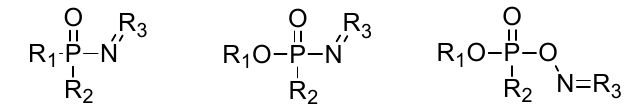
Figure 2. Possible scaffolds for the A-series nerve agents already reported in the literature [11].